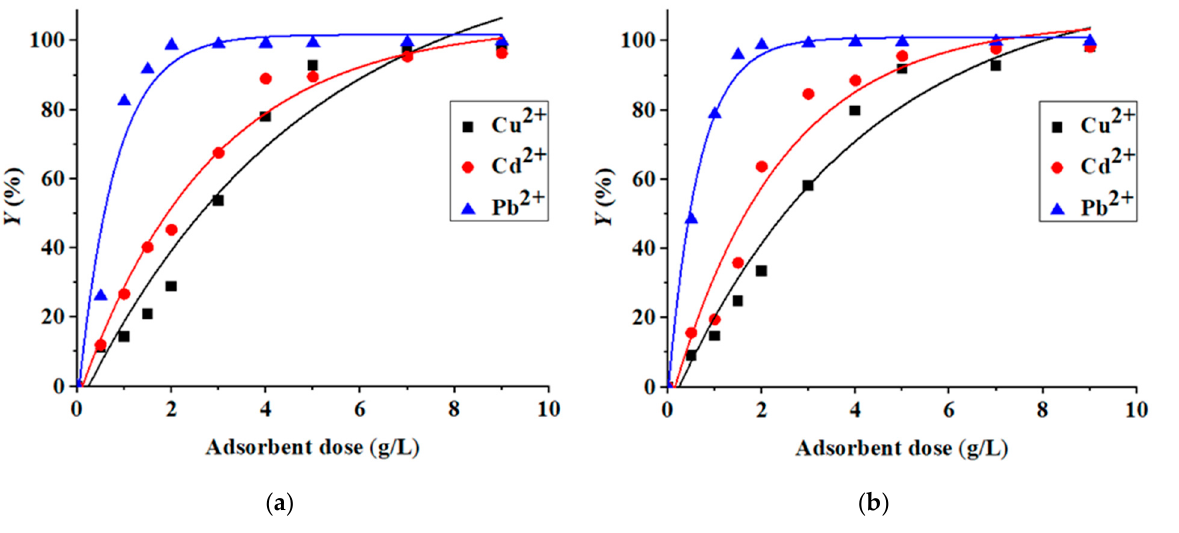
Figure 6. Removal efficiency of heavy metal cations (Cu 2+ , Cd 2+ , Pb 2+ ) depending on the adsorbent dose: ( a ) removal efficiencies determined at 300 K, and ( b ) removal efficiencies determined at 323 K. Table 4. Comparison of the adsorption capacities of keratin-based materials for retention of heavy metal